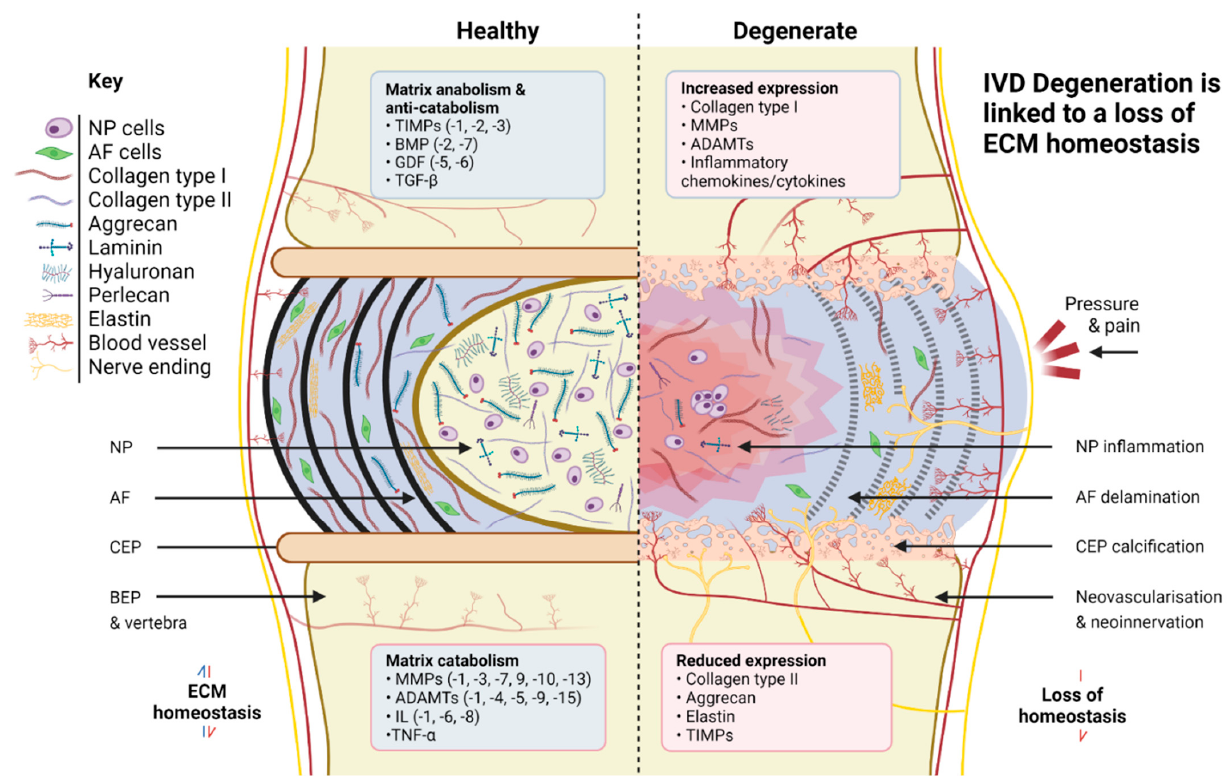
Figure 1. Comparison of healthy and degenerate IVD ECM. Created with Biorender.com.